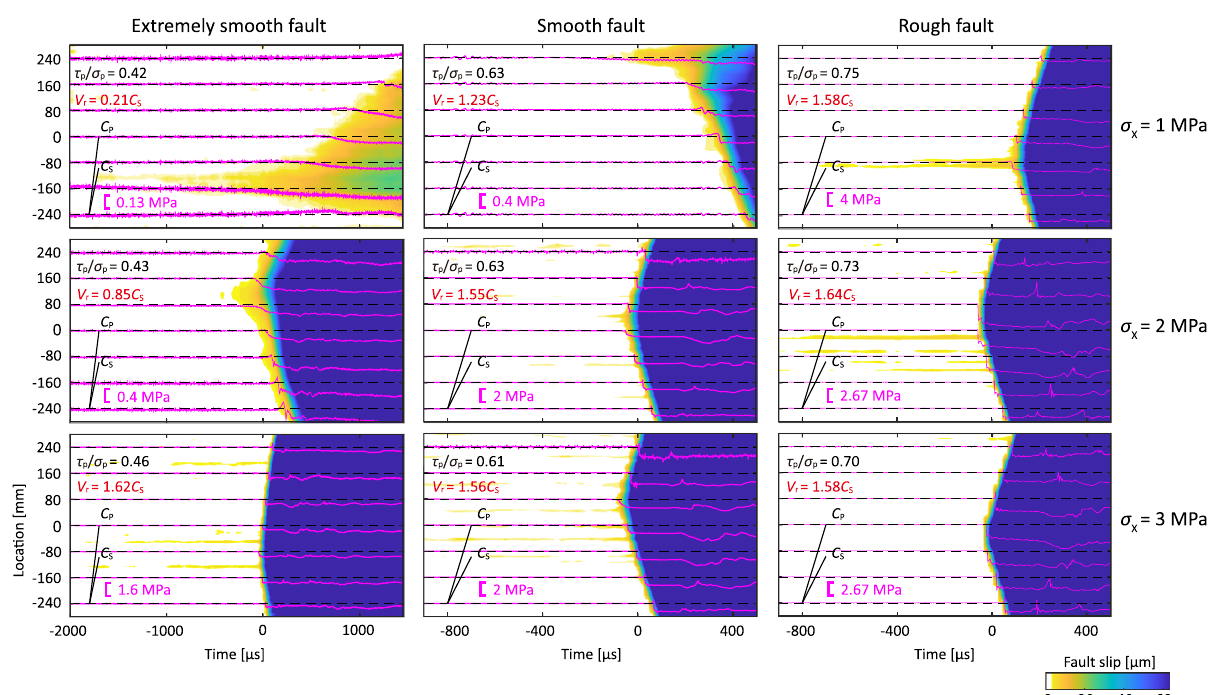
Fig. 2 | Nucleation and rupture process of spontaneous events. Each subgraph shows the space-time distribution of fault parallel slip. Colors indicate the dis- tributed measurements of fault slip obtained from optical images. The magenta lines correspond to the shear stress measured using the shear strain gauges. The